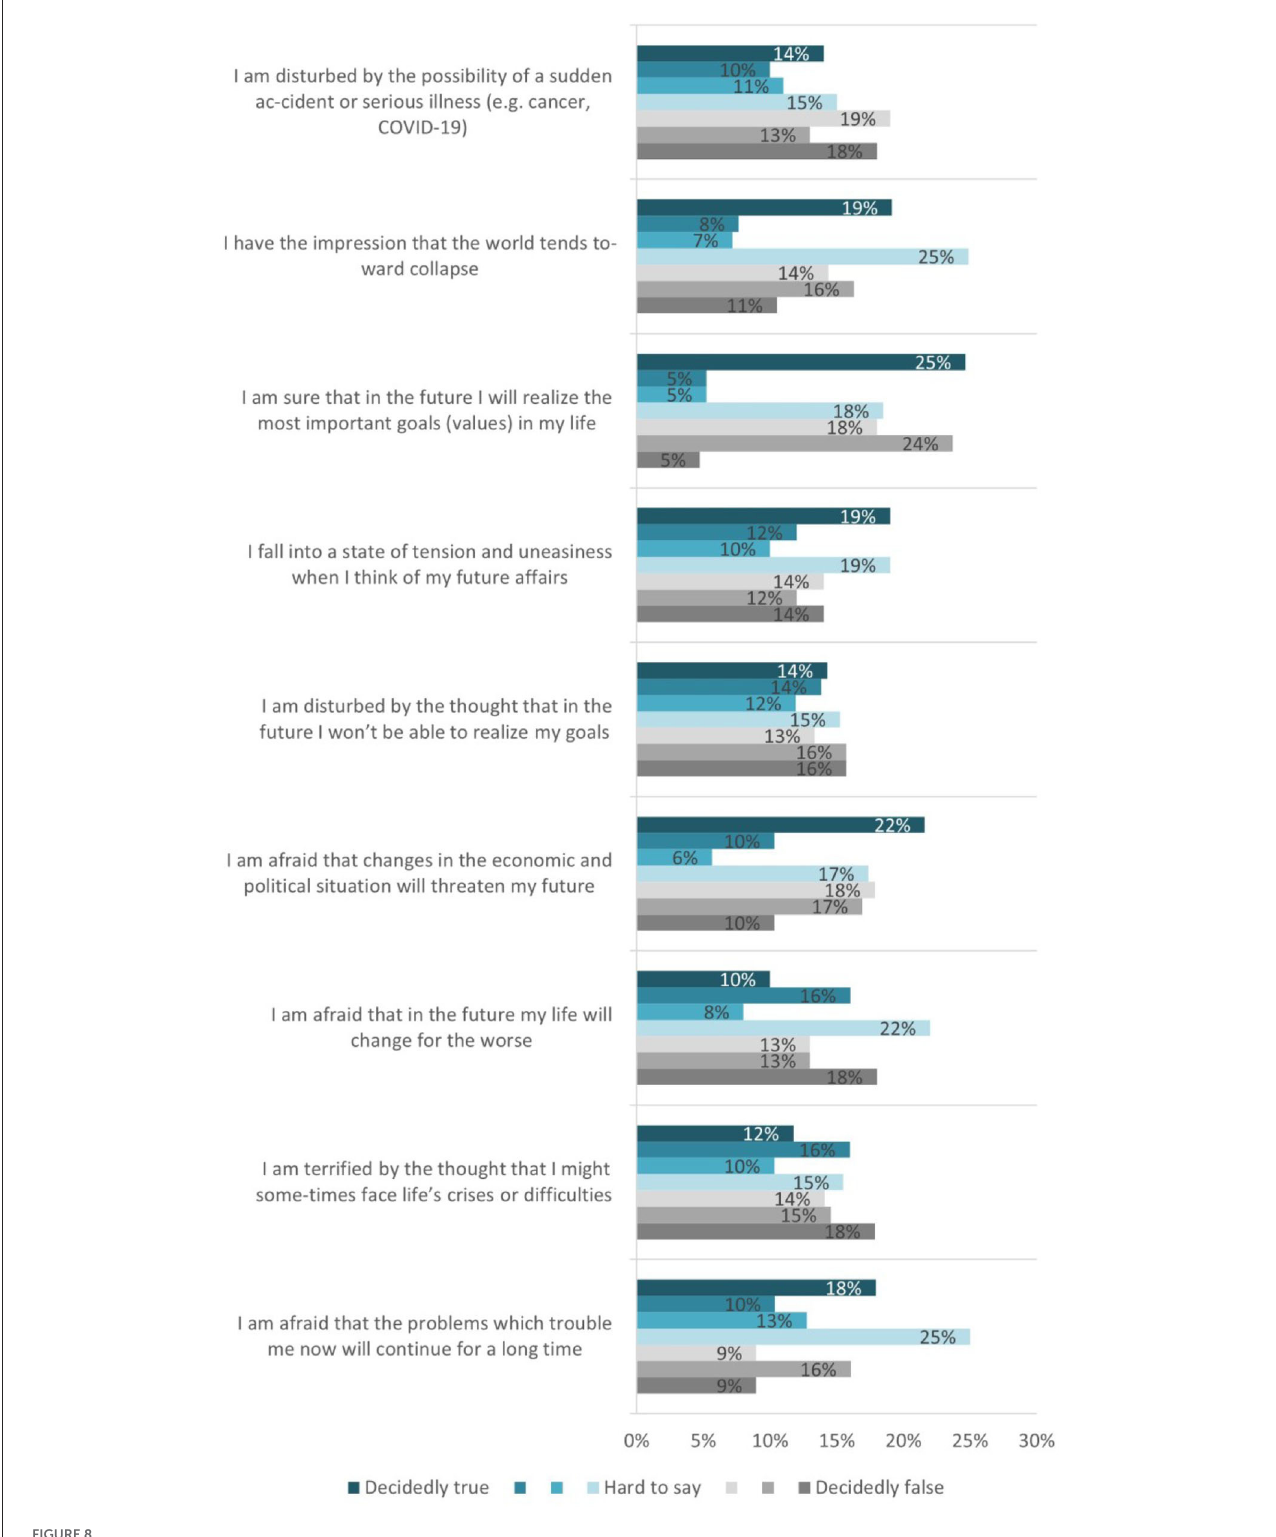
FIGURE8 Students’ health and wellbeing risk factors self-evaluation.